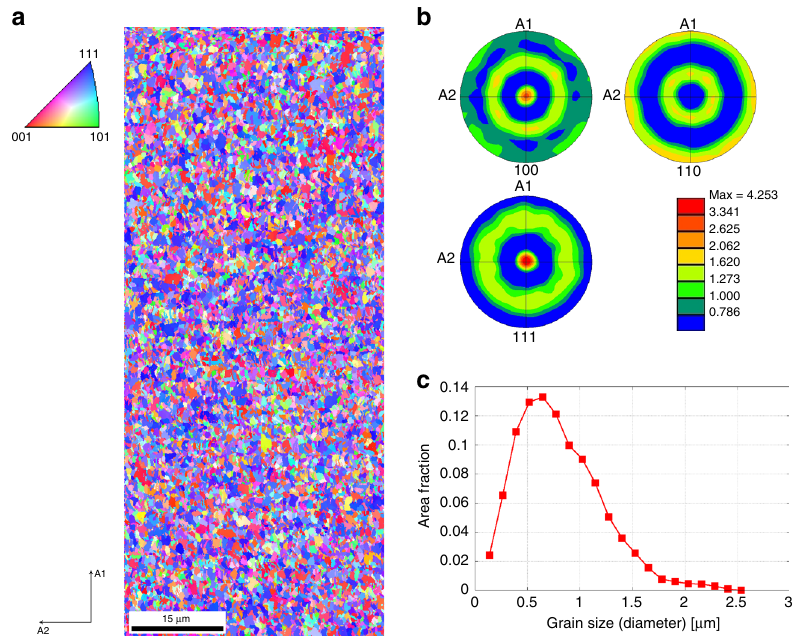
Fig. 2 Characterization of Cu thin fi lms. a EBSD micrograph showing the inverse Pole Figure map of the as-deposited Cu thin- fi lm. b Pole fi gures and c grain size